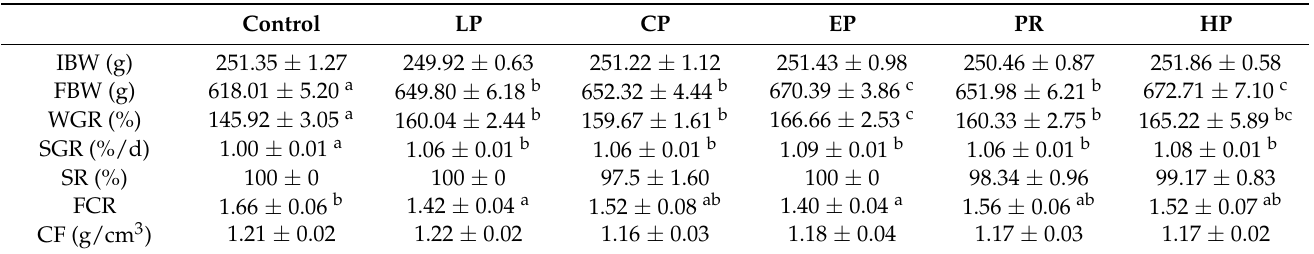
Table 6. The growth performance of Oncorhynchus mykiss fed with the experimental diets.